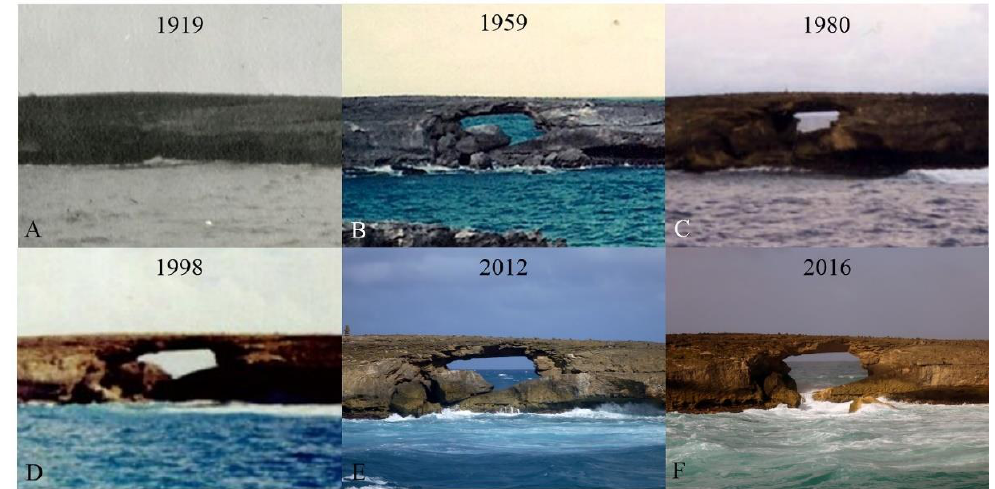
Figure 9. Sequence of images showing evolution of the sea arch on Kukuiho’olua Island, near Laie Point, Hawaii. Images taken from approximately the same location. Image ( A ) is the earliest known image of the island, showing no arch. Image ( B ) is the second earliest-known image of the island and the first to show the arch, indicating that the arch formed sometime between 1919 and 1959. Images ( C ), ( D ), and ( E ) show the arch in a fairly steady-state for several decades. Image ( F ) shows the dramatic change after the large waves of 2016.